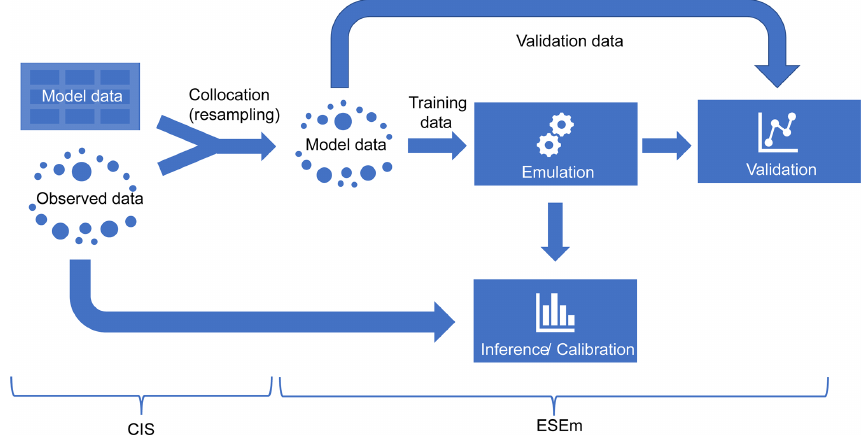
Figure 1. A schematic of a typical workflow using CIS and ESEm to perform model emulation and calibration. Note that only the locations of the observed data are used for resampling the model